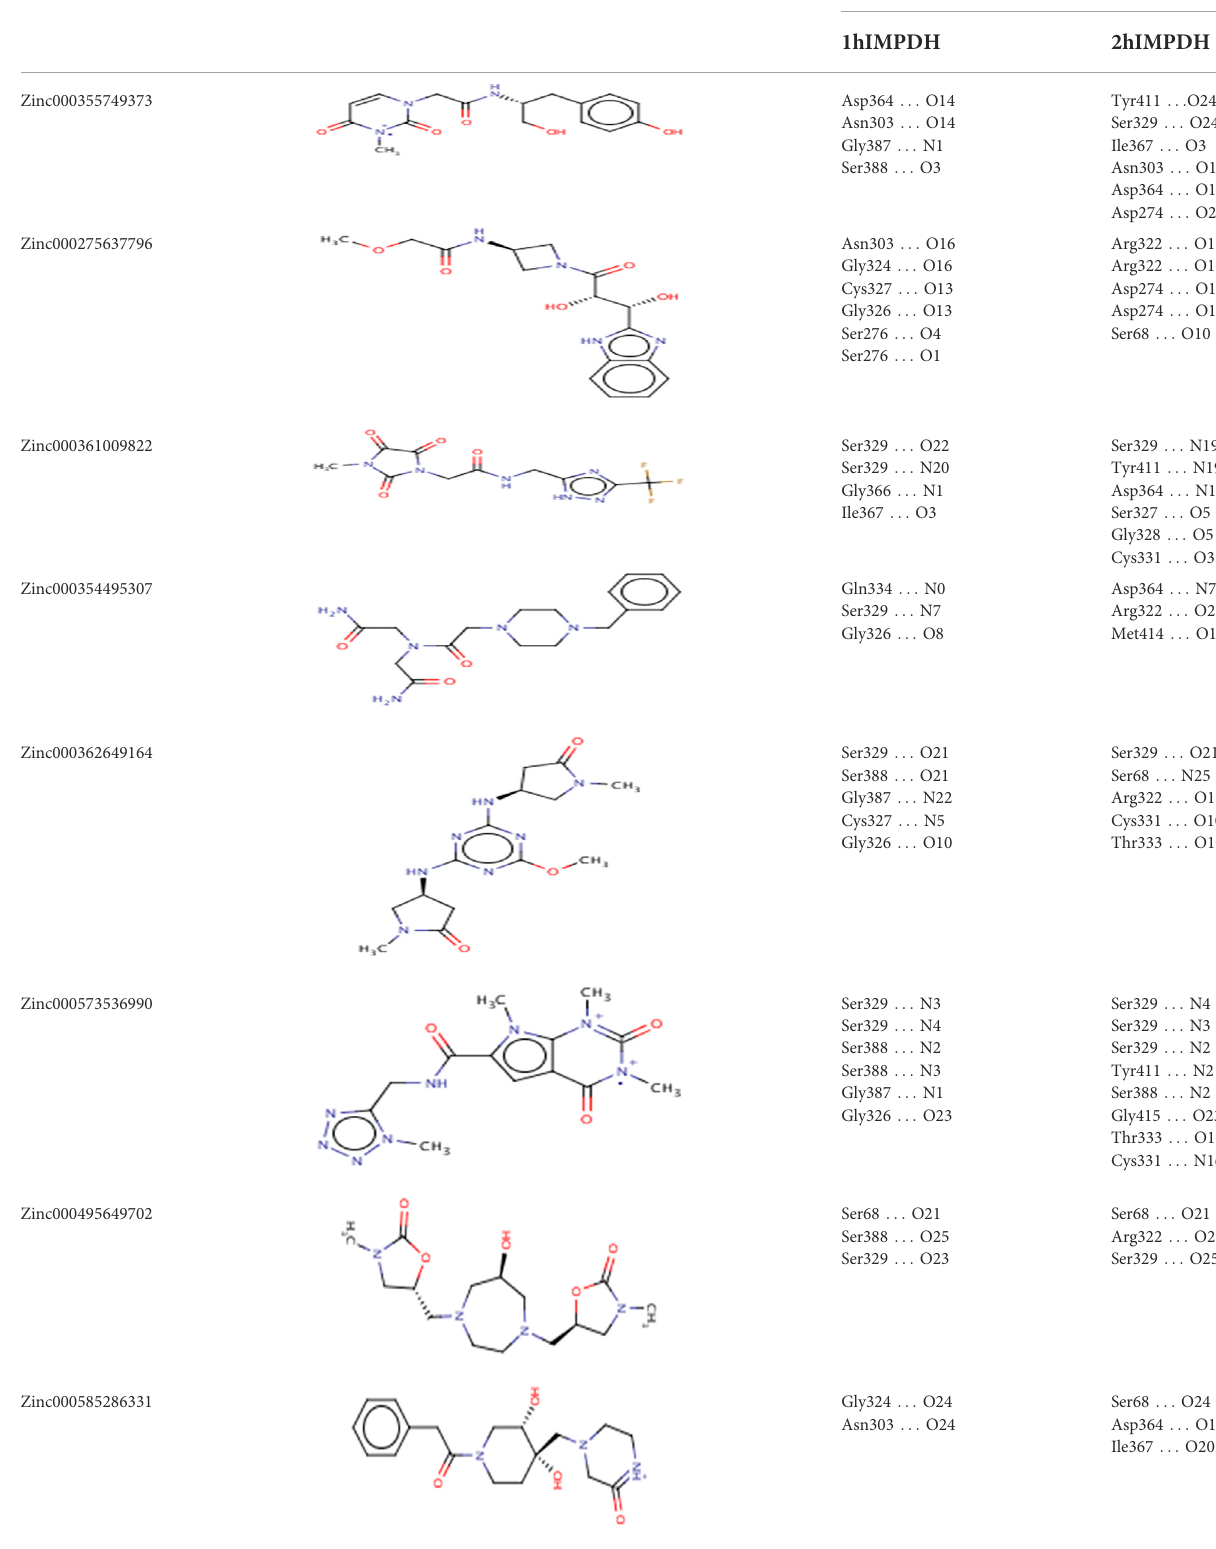
TABLE 3 Structures and hydrogen bonds of topmost ligands in complex with IMPDH isoforms over double-step